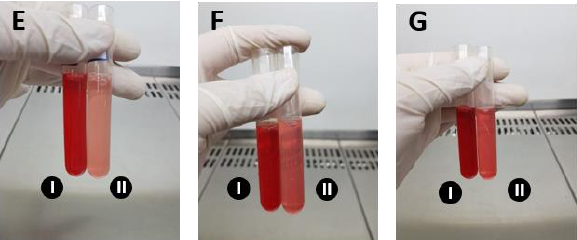
20 of 23 Table 2. Summary of the spiral microchip best performance results in the isolation of WBC, RBC, and Platelets based on the inlet sample flow rate and hematocrit. Sample Hematocrit